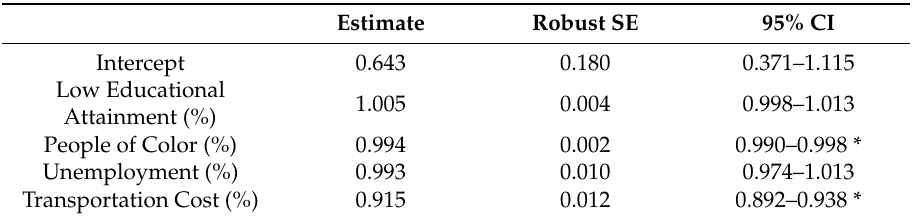
Table 4. Results of multivariate model of COVID-19 testing rates based on SES and people of color variables. Estimates and 95% CIs are the exponentiated coe ffi cients of the Poisson model, with statistically significant associations indicated with an